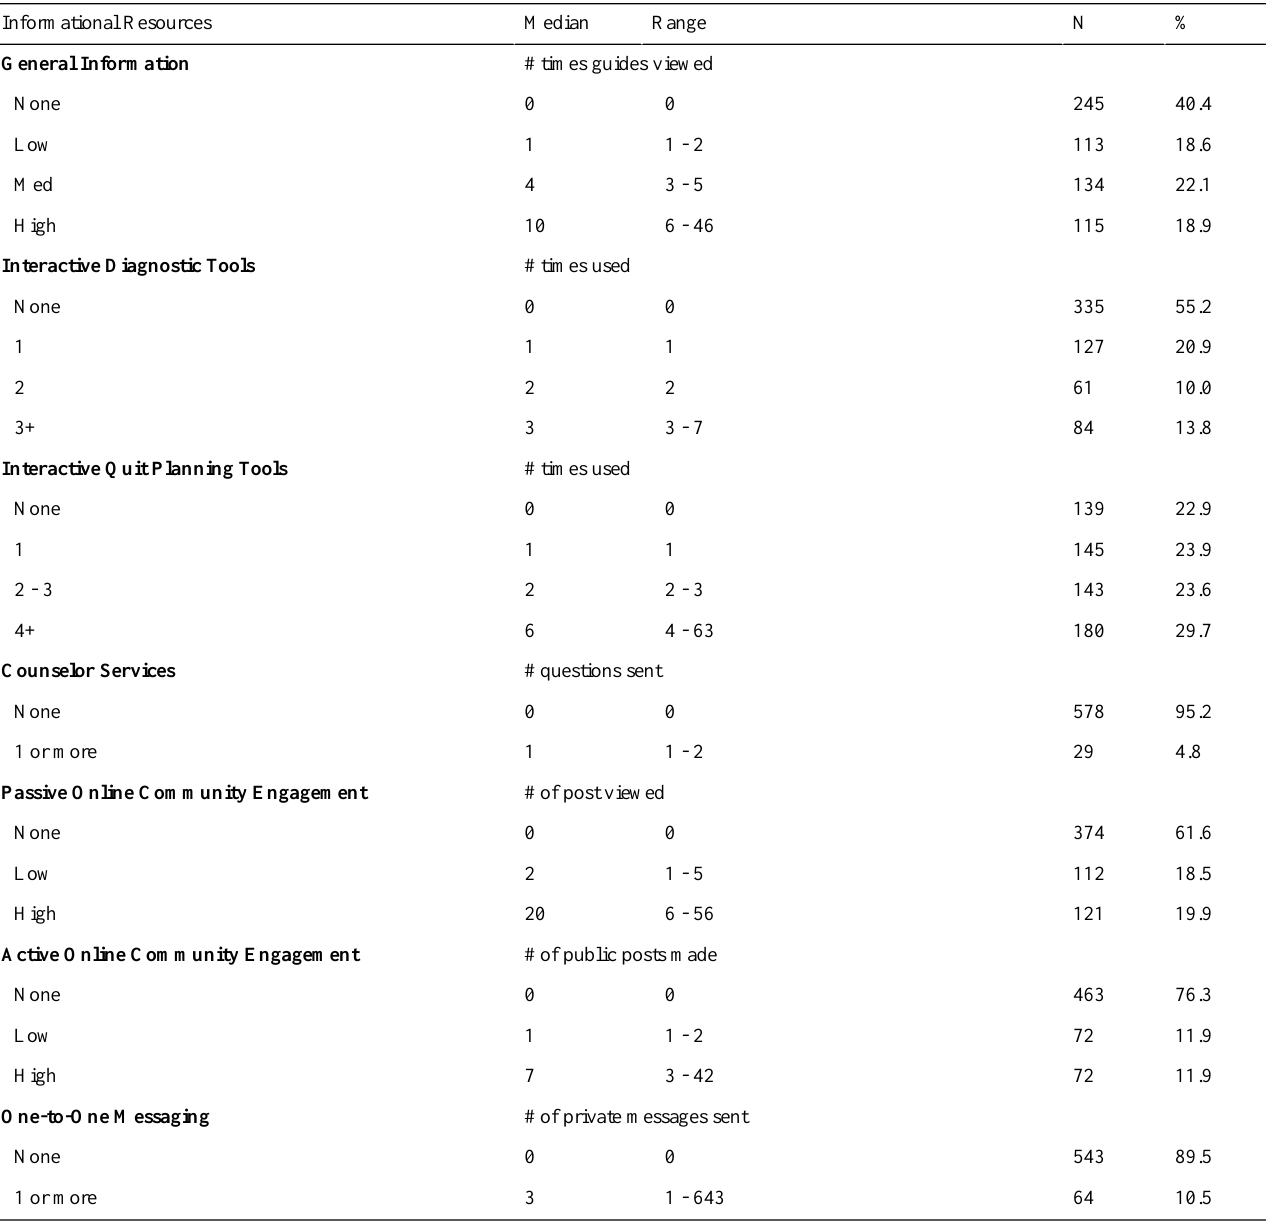
Table 2. Website utilization patterns in the 6 months after initial